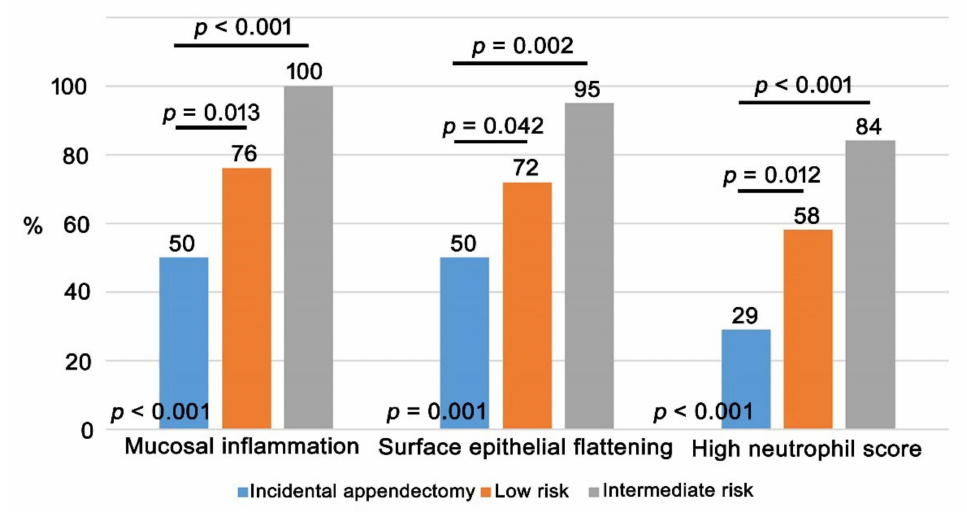
Figure 2. Comparison of histologic findings between incidental appendectomy cases and negative appendectomy cases that were classified according to AIR score-based risk stratification. Negative appendectomy cases with low risk and intermediated risk displayed more frequent mucosal inflammation, surface epithelial flattening and high neutrophil score than incidental appendectomy cases ( p < 0.05, respectively). Additionally, positive linear correlations were shown in the comparison of these histologic features among incidental appendectomy cases, negative appendectomy cases with low risk and intermediate risk ( p < 0.05, respectively), of which p value is presented in the bottom of each graph.